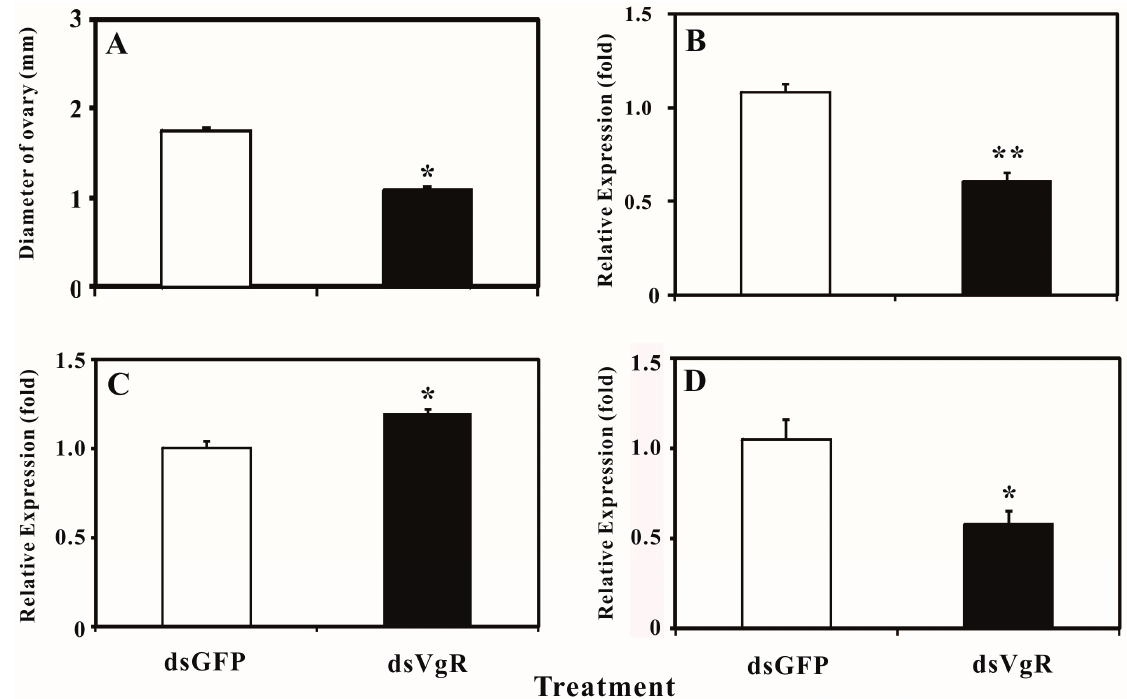
Figure 5. The ovary diameter and expression levels of BdVgR , Bdyp1 and Bdyp2 72 h after injected with dsRNA. ( A ) The diameters of ovaries; ( B ) The mRNA level of BdVgR ; ( C ) The mRNA level of Bdyp1 ; ( D ) The mRNA level of Bdyp2 . The bars represent the mean ± SE. The asterisks indicate significant difference with t -test, * p < 0.05 or ** p <